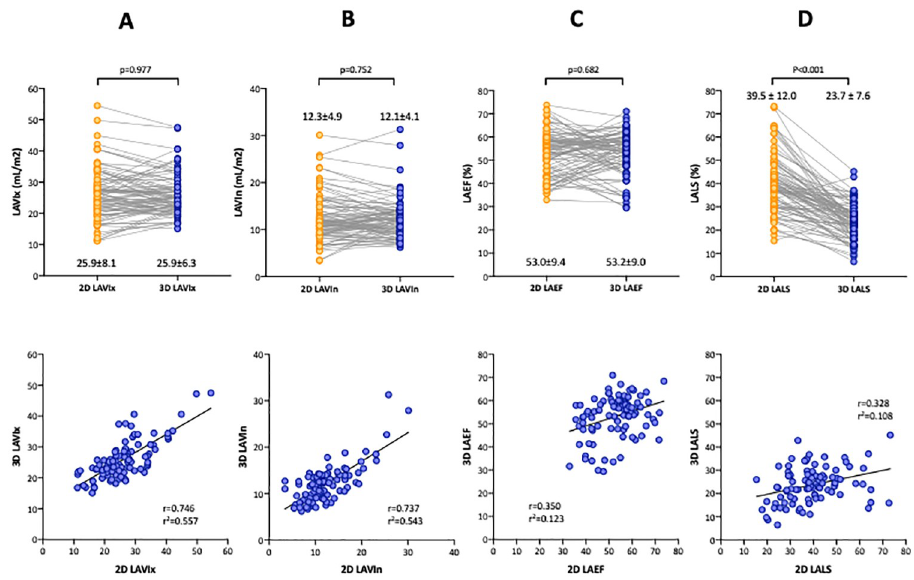
Fig 5. A paired comparison and correlation of left atrial volumes, emptying fraction, and strain between 2DE and 3DE. A and B: Indexed maximal and minimal left atrial volumes (LAVIx, LAVIn) between 2DE and 3DE (upper panel) and their correlation (lower panel). C: Left atrial emptying fraction (LAEF) between the two methods (upper panel) and their correlation (lower panel). D: Left atrial strain between the two methods (upper panel) and their correlation (lower panel).